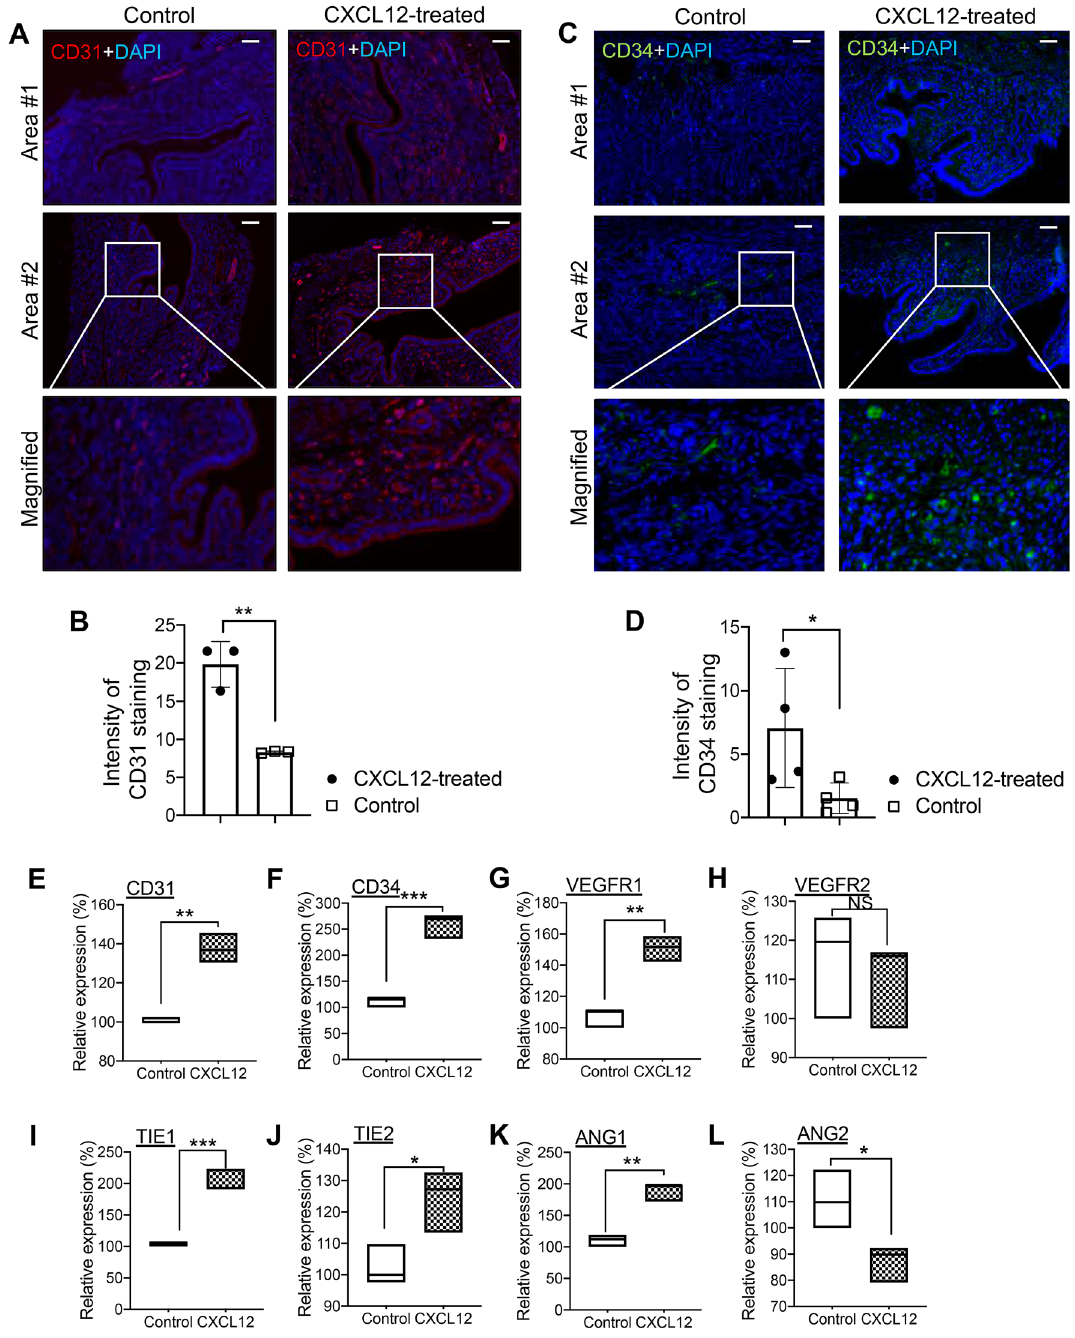
Figure 5. Promoted endometrial angiogenesis with intra-uterine CXCL12 treatment. IF staining of CD31 ( A , B ) or CD34 ( C , D ) in longitudinally sectioned mouse uterus harvested 8 days after CXCL12 intrauterine infusion. Saline-treated endometrium were used for control. Scale Bar; 100um. Intensity of CD31 and CD34 staining was quantified and summarized in graphs ( B ) and ( D ). Data are from 4 independent experiments, and analyzed using unpaired Student t test analysis including p values (*< 0.05, **< 0.01). ( E-L ) QRT-PCR analysis of CD31, CD34, VEGFR1, VEGFR2, TIE1, TIE2, ANG1 and ANG2 in CXCL12-treated uterus samples compared to controls. Data are from 3 independent experiments, and analyzed using unpaired Student t test analysis including p values (*< 0.05, **< 0.01, ***< 0.001, NS; not